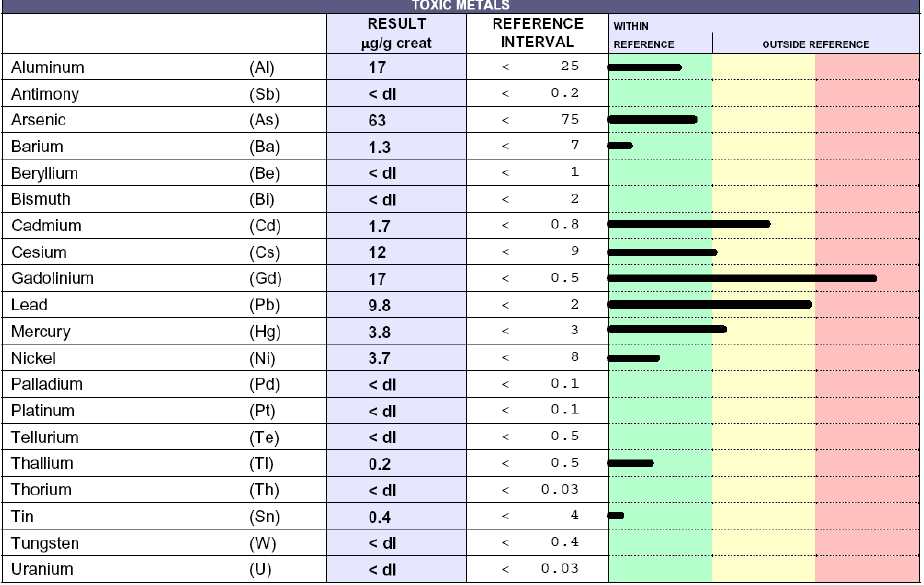
Figure 4. Toxic-metal levels measured by inductively coupled plasma mass spectrometry in the patient urine collected over 12 h reported in µg/g creatinine. The black lines indicate the levels of each toxic metal. Whitin the green column the values are considered normal, while in the yellow and in the red columns high and very high values are reported, respectively. The patient was affected by multiple sclerosis and underwent 60 chelation therapy applications over a 20-month period.